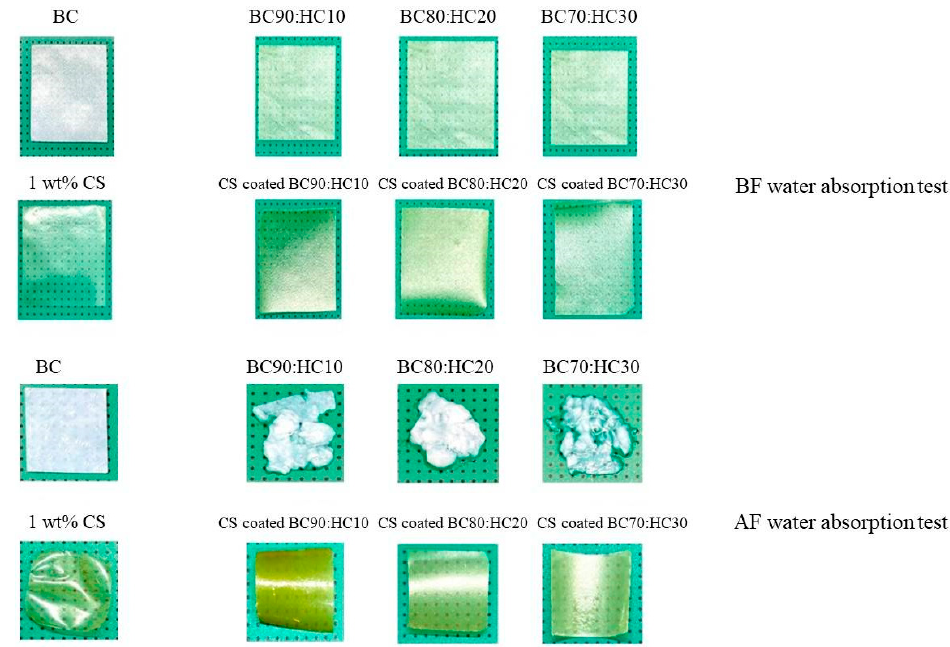
Figure 2. Physical appearance of BC film, CS film, BC:HC films, and CS-coated BC:HC films.